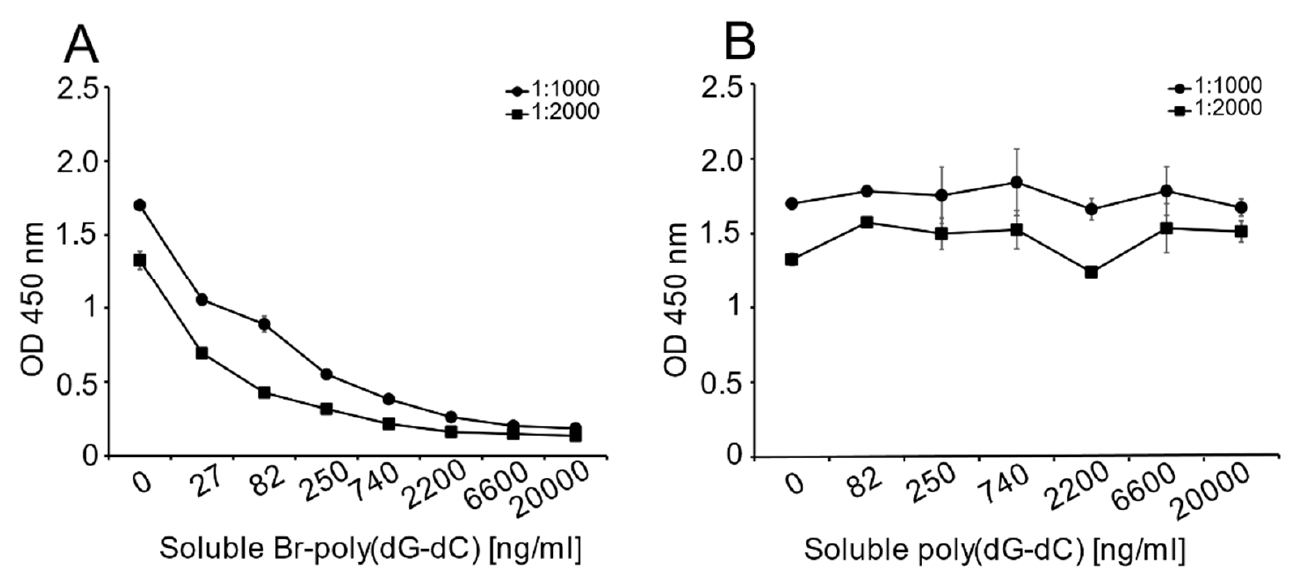
Figure 3. The effects of soluble Br-poly(dG-dC) on the binding of polyclonal anti-Z-DNA antibodies to MC DNA. To show the specificity of the polyclonal anti-Z-DNA antibodies for Z-DNA in MC DNA, the ability of soluble Br-poly(dG-dC) to inhibit antibody binding was tested ( A ). Br-poly(dG-dC) was used a source of Z-DNA; unbrominated poly(dG-dC) was the control ( B ). The binding of the antibody preparations at dilutions of both 1:1000 and 1:2000 was tested. The results are presented as OD 450 nm values. All treatments were performed in duplicate. Means and standard deviations are shown.